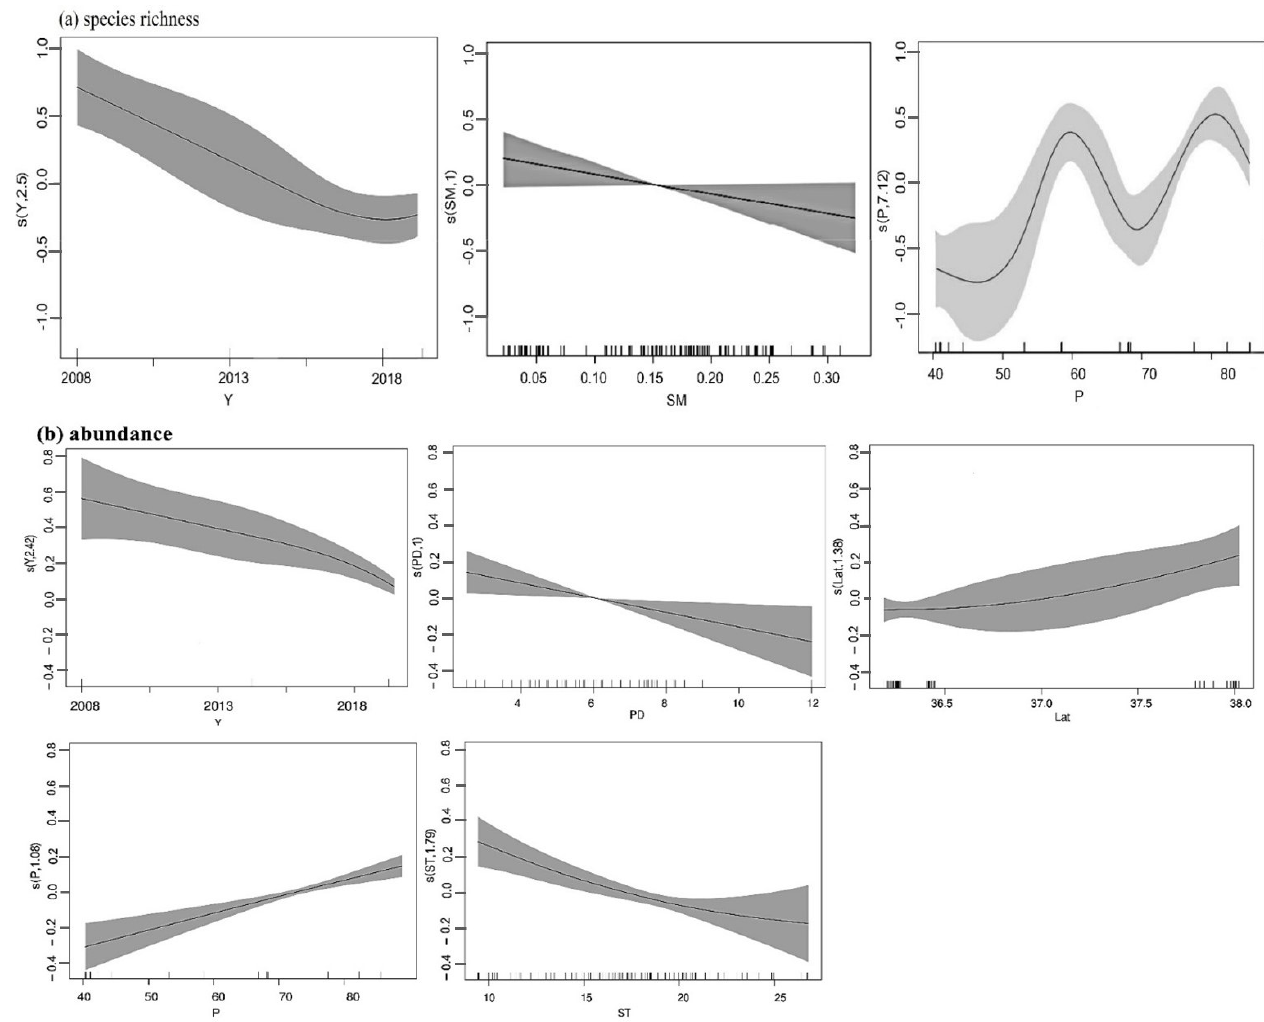
Figure 4. Plots of significant explanatory variables for the dependent variables species richness ( a ) and abundance ( b ). P, precipitation; Lat, latitude; ST, soil temperature; PD, plant diversity; SM, soil temperature. The vertical axes are expressed in logits, the value (s) represents the smoothing fitting value of an explanatory variable of carabid beetles, and the ordinate in parentheses is the estimated degree of freedom. The shaded areas represent confidence intervals.